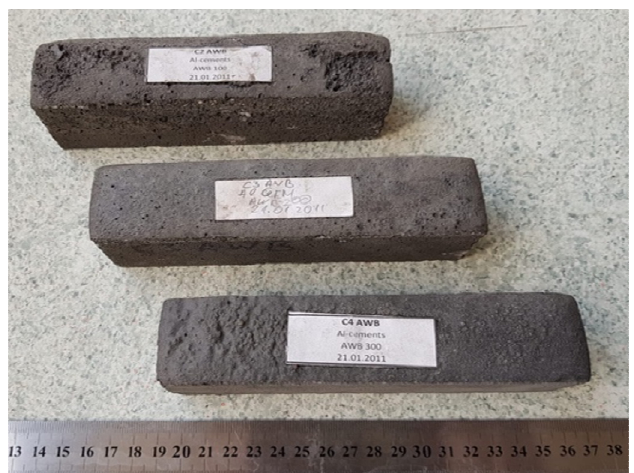
Figure 11. Sample of concrete containing boron 40 × 40 × 160 mm 3